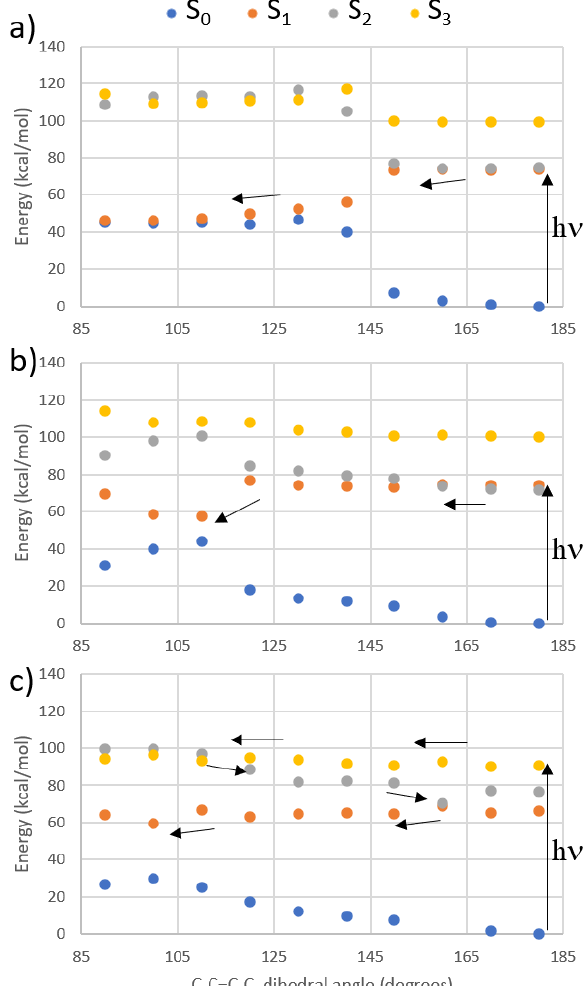
Figure 5. Single State (SS)-CASPT2 photoisomerization pathways when irradiating ( a ) S 1 , ( b ) S 2 , and ( c ) S 3 , shown with arrows.